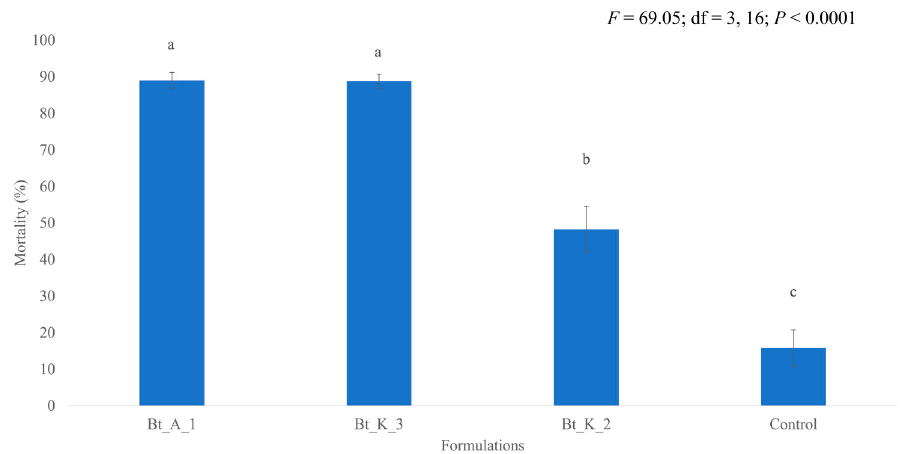
Figure 1. Mean ( ± standard error) mortality of Stenoma impressella larvae achieved with three com- mercial formulations of Bacillus thuringiensis , each at a dose of 500 g/Ha, seven days after spraying under field conditions (i.e., 26.2 ± 3.4 °C, 84.6 ± 27.1% relative humidity, and 137 mm rainfall during the bioassay). Different letters indicate significant differences (Tukey, p = 0.05).